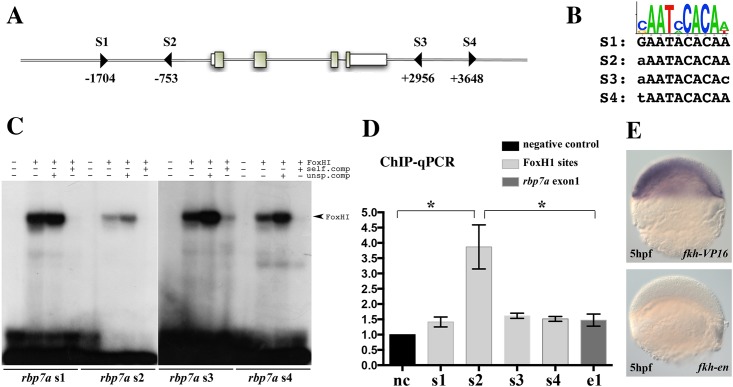

rbp7a is a direct target of FoxH1.[A] Schematic drawing of the rbp7a gene highlighting 4 potential FoxH1 binding sites (triangles: S1, S2, S3, and S4). Exons are indicated by boxes, the numbers correspond to the distance form the transcriptional start site. [B] Sequence comparison of the mouse FoxH1 consensus log [37] with the four potential sites in rbp7a. [C] In vitro EMSA studies with translated FoxH1 protein with oligonucleotides containing the four potential FoxH1 binding sites (sequences and positions were shown in [A, B]). Competition experiments with unspecific (unsp.comp) and specific (self.comp) unlabeled oligonucleotides were added to verify the binding specificity. [D] In vivo chromatin immunoprecipitation (ChIP-qPCR) experiments performed with 6hpf eGFP-foxH1 mRNA injected MZsur embryos. Bars show the enrichments of DNA fragments in the regions of FoxH1 binding sites in relation to a negative control region (rhodopsin promoter region) that was lacking FoxH1 binding sites (*P<0.05; error bars indicated the SEM). [E] Induced and depleted rbp7a expression in 5hpf wild type embryos after injection of fkh-vp16 and fkh-en mRNA, respectively.